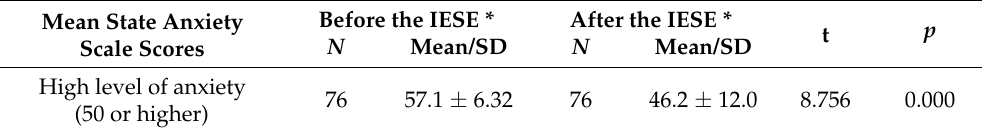
Table 2. Comparison of the participants’ state anxiety scale scores before and after the IESE.